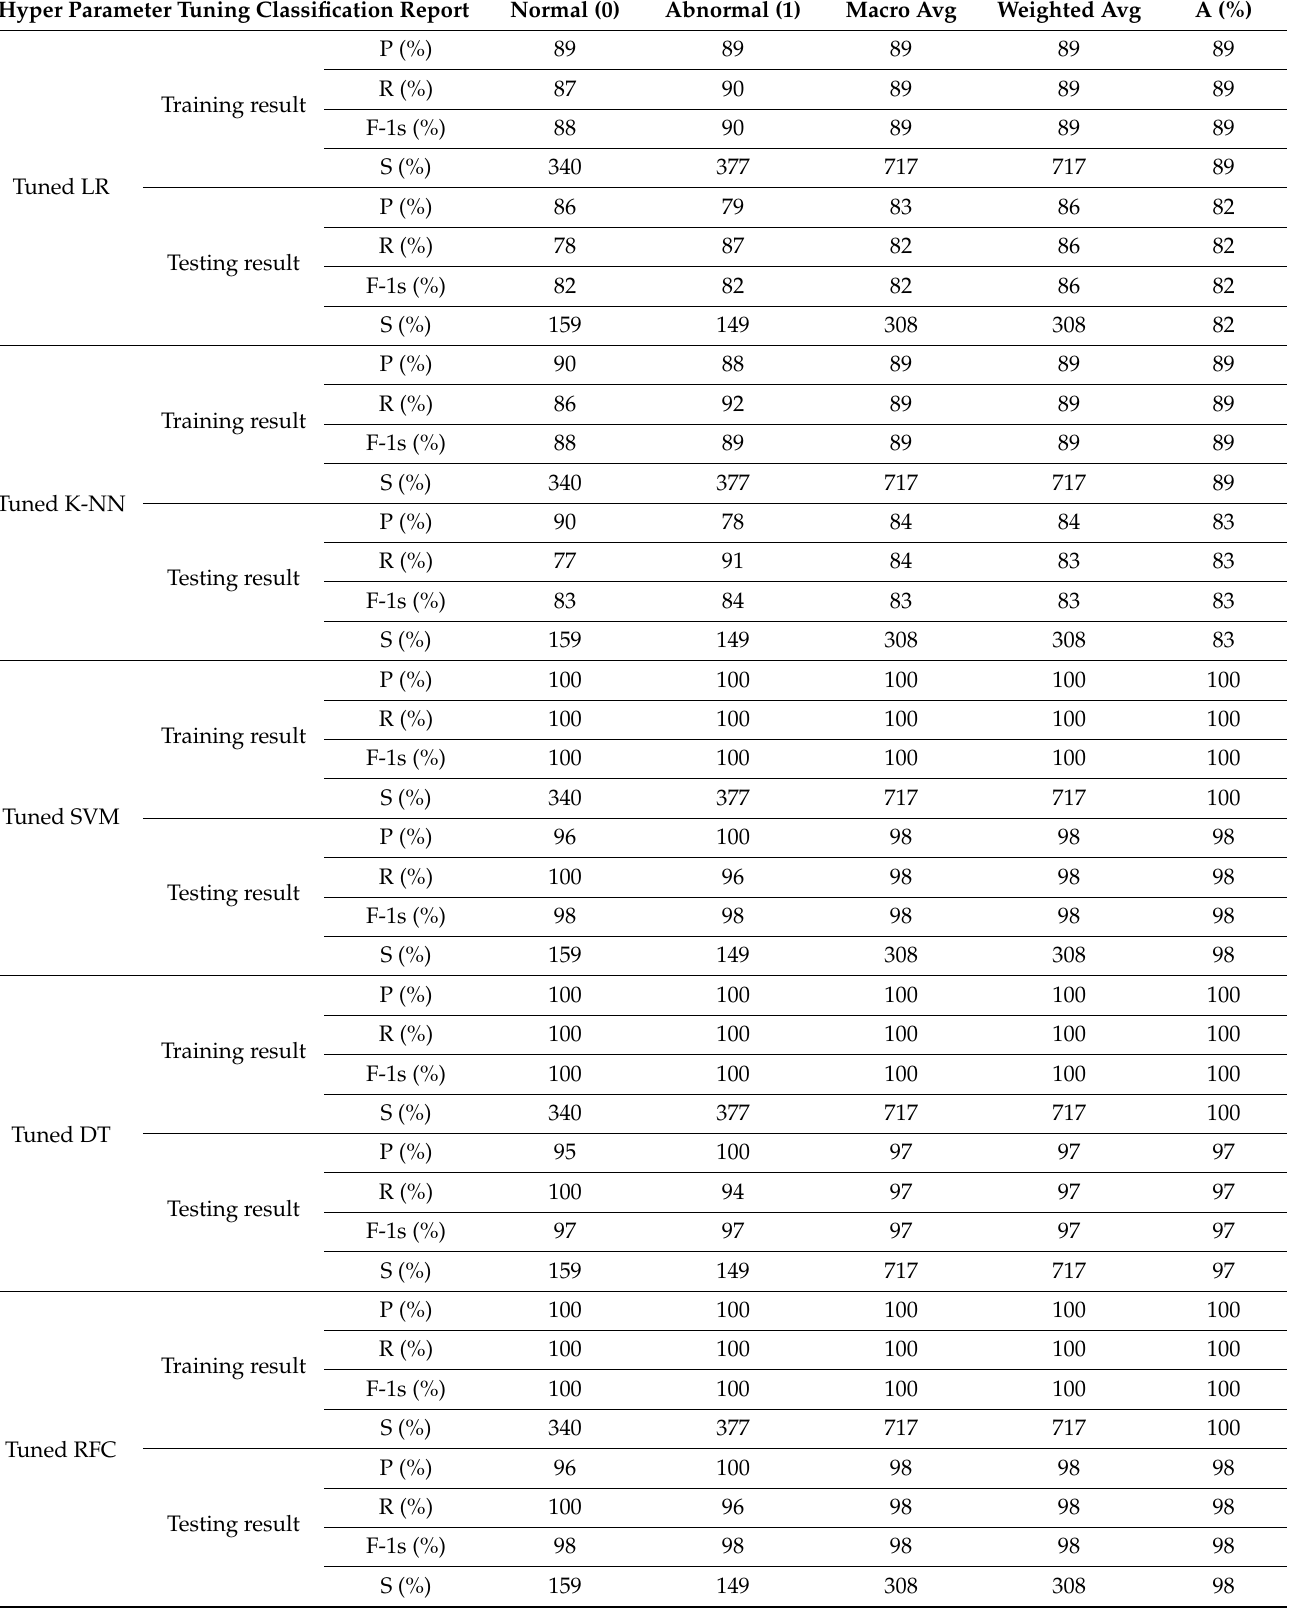
Table 11. For the training set and the test set, classification report models were evaluated and compared using a hyperparameter tuning